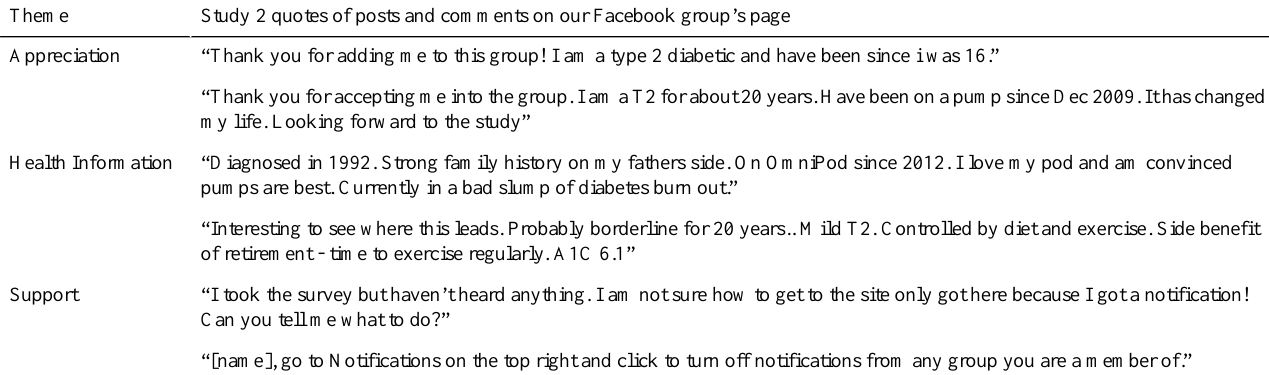
Table 6. Study 2 posts and comments on study group’s Facebook